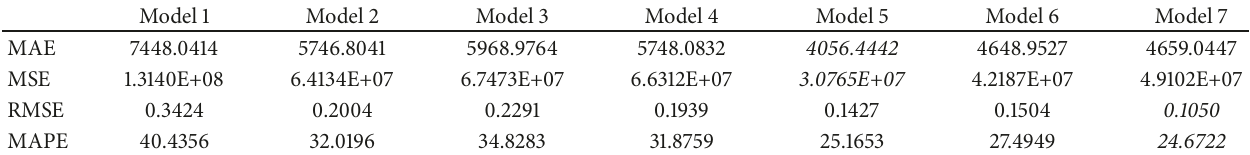
Table 6: MAE, MSE, RMSE, and MAPE (%) of predicting the number of influenza